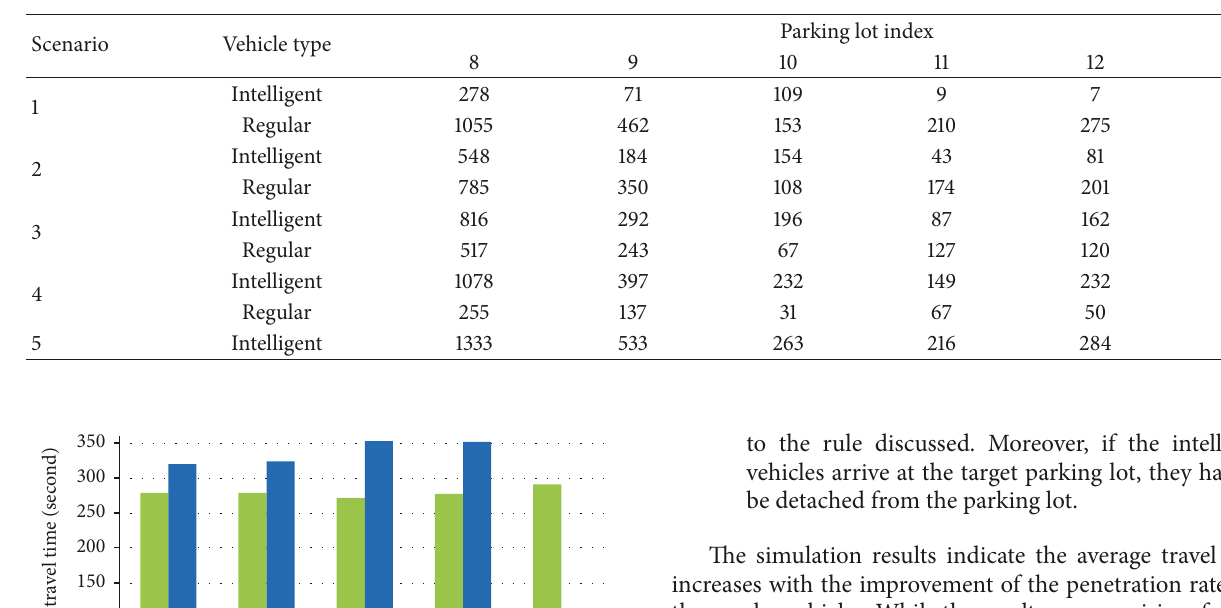
Table 2: Parking demands served by each parking lot.